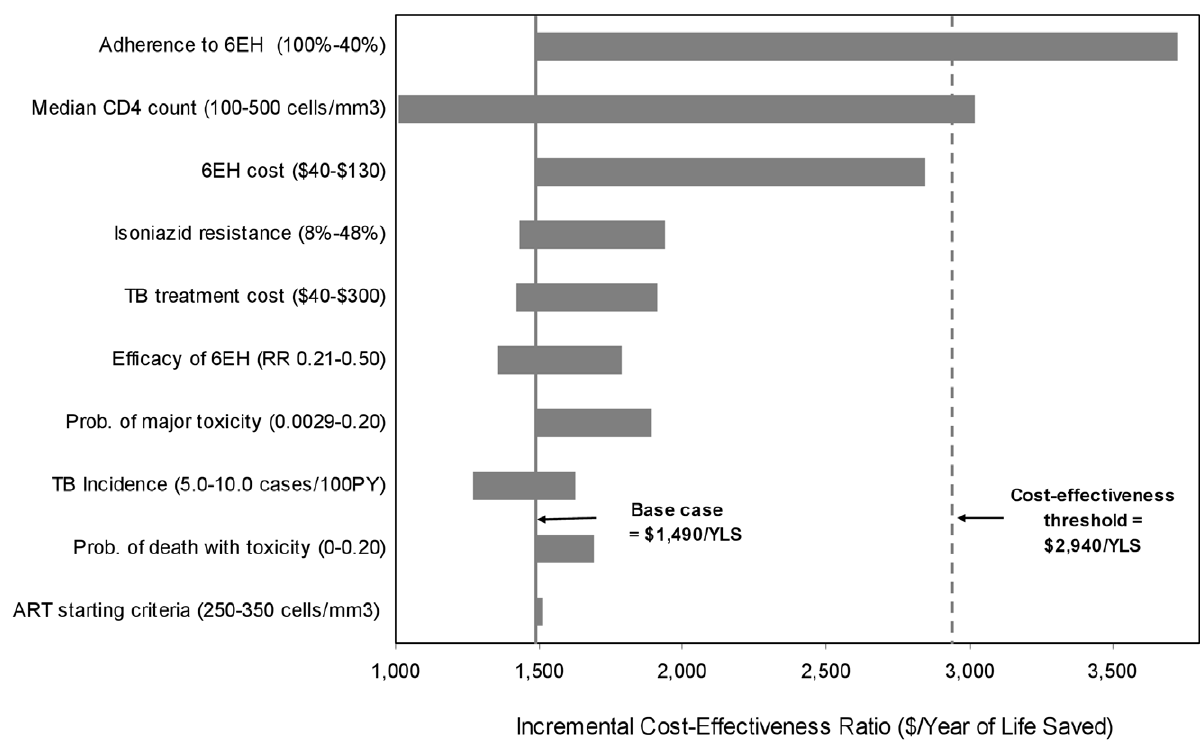
Discounted mean per person lifetime cost, Strategy 2009 USD